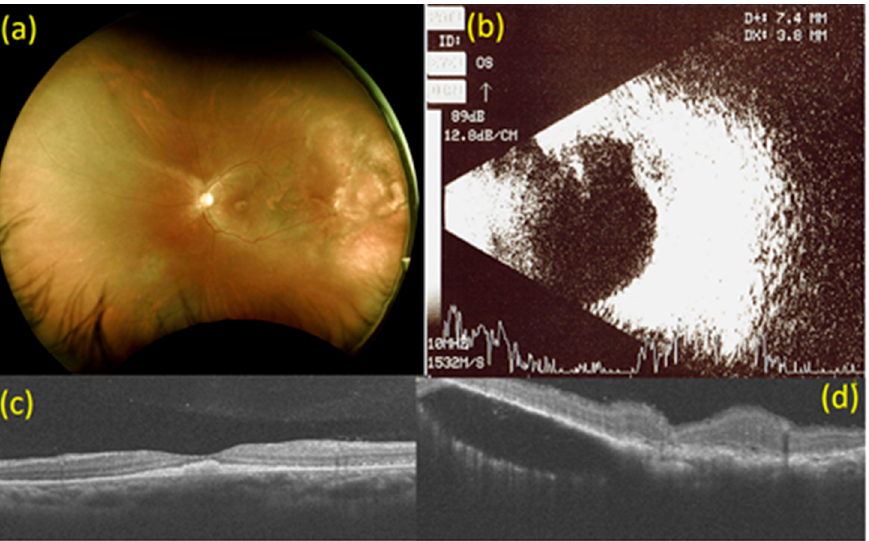
Figure 1. Images at baseline. ( a ) Fundoscopy at baseline. Multiple white-yellowish spot lesions at the fovea with multiple irregular, ill-defined white lesions at 2 to 3 o’clock on the peripheral side in the left eye. ( b ) B-mode ultrasonography at baseline. A choroidal mass with an extension of 7.4 × 3.8 mm on the superior temporal side in the left eye. ( c ) Macular optical coherence tomography (OCT) scan at baseline. Subretinal elevated solid lesion at the fovea in the left eye. ( d ) OCT scan of choroidal mass at 2 to 3 o’clock on the peripheral side in the left eye at baseline. Subretinal fluid collection at 2 to 3 o’clock on the peripheral side in the left eye.